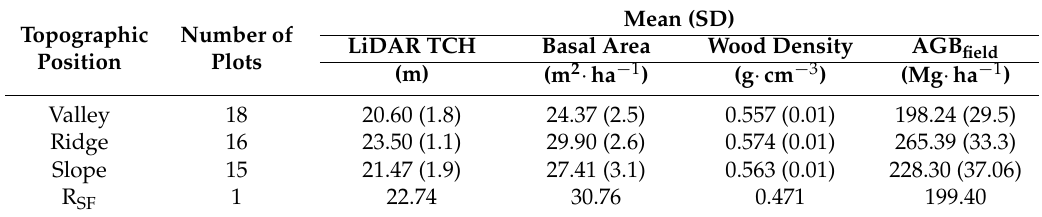
Table 4. Summary Statistics for the LiDAR plot 1-ha grid of study